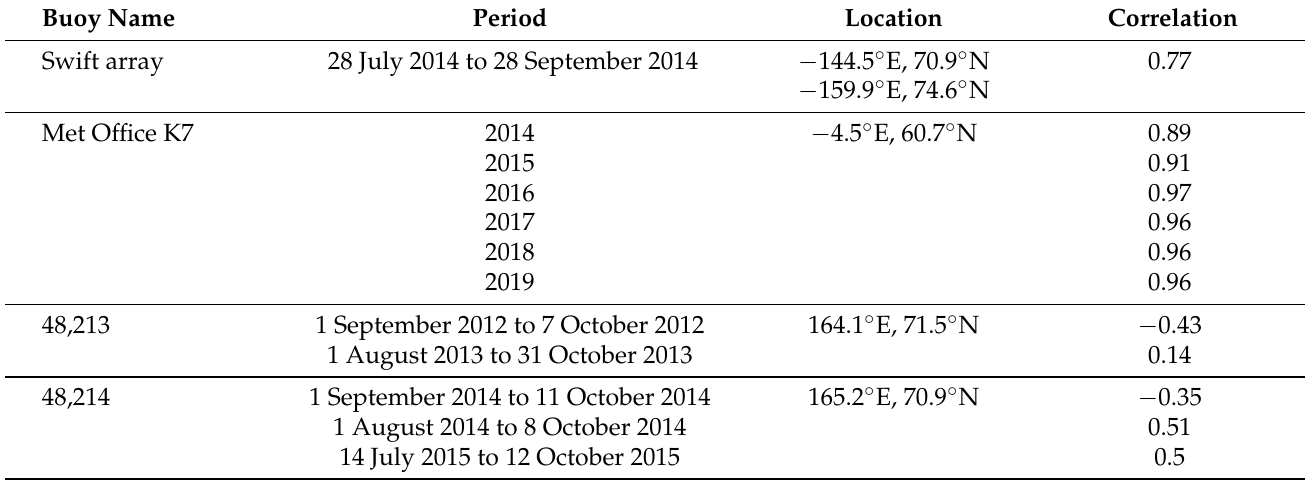
Table 1. Wave buoy data used in this study, plus correlation to our new SWH. All buoy locations are under the SAR mode operation of CS2. Pearson correlation coefficients between our new SWH and the wave buoy measurements are listed. See Section 3.5 for